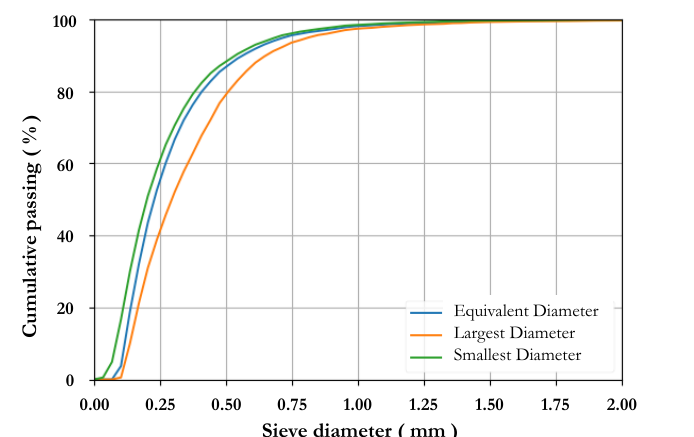
Figure 2: Example of a porosity distribution in the UHPC sample obtained from X-ray com- puted tomography analysis before impact experiments. (The smallest and largest diameter are obtained with equivalent ellipse analysis